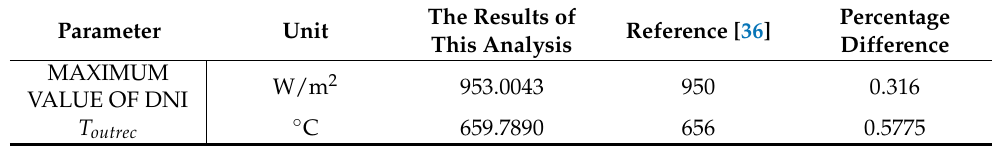
Table 9. Validation results for the SPT